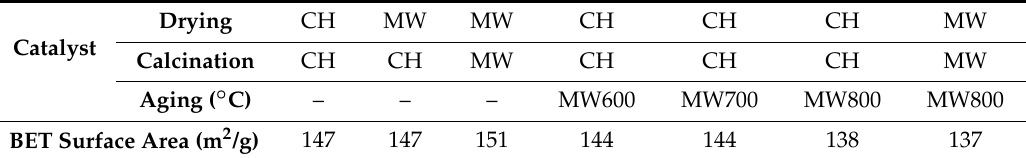
Figure 1. Comparison of Pt dispersion of samples conventionally dried (110 °C overnight) and dried by microwave irradiation (210 °C, 15 min). The dispersion was measured by CO chemisorption and H 2 –O 2 titration. Both samples were calcined in conventional furnace. Table 2. BET surface area of all prepared samples.